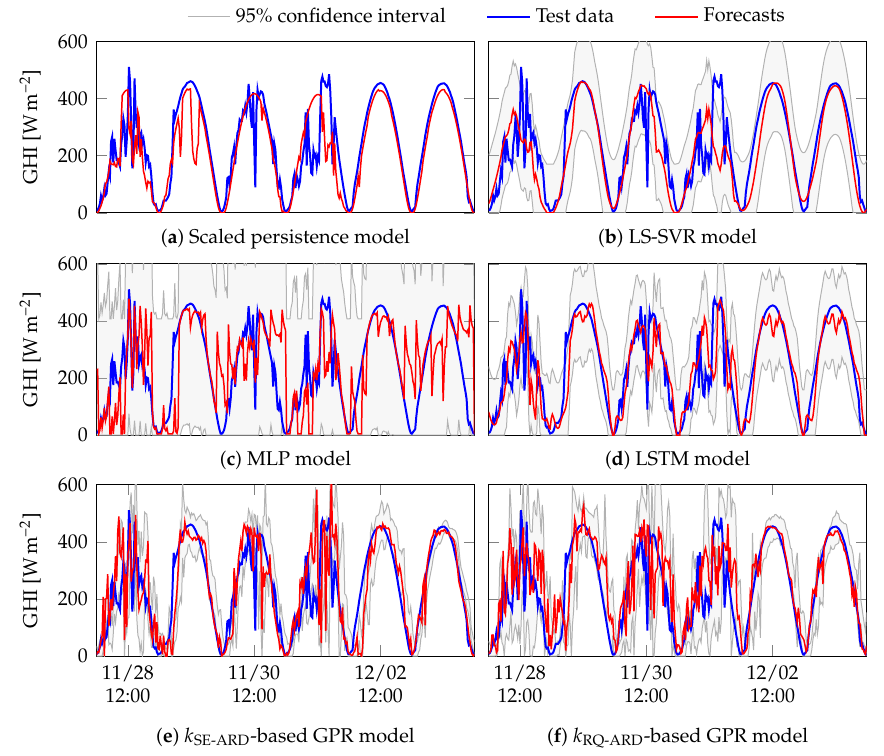
Figure 10. Examples of 4h forecasts of GHI given by the models included in the comparative study. The values of DMAE for all models are stored in Table 3. Based on this criterion, the LS-SVR model and the scaled persistence model gave the worst results for all horizons compared to the other models. This criterion combined the temporal distorsion between the forecasts and test data with the absolute magnitude error. For lower horizons, the scaled persistence model gave good results according to its nRMSE values (Table 2) and its performance at the lowest horizon (10 min) was practically similar to the performance of ANN models (nRMSE = 20.20%) and slightly better than the performance of GPR